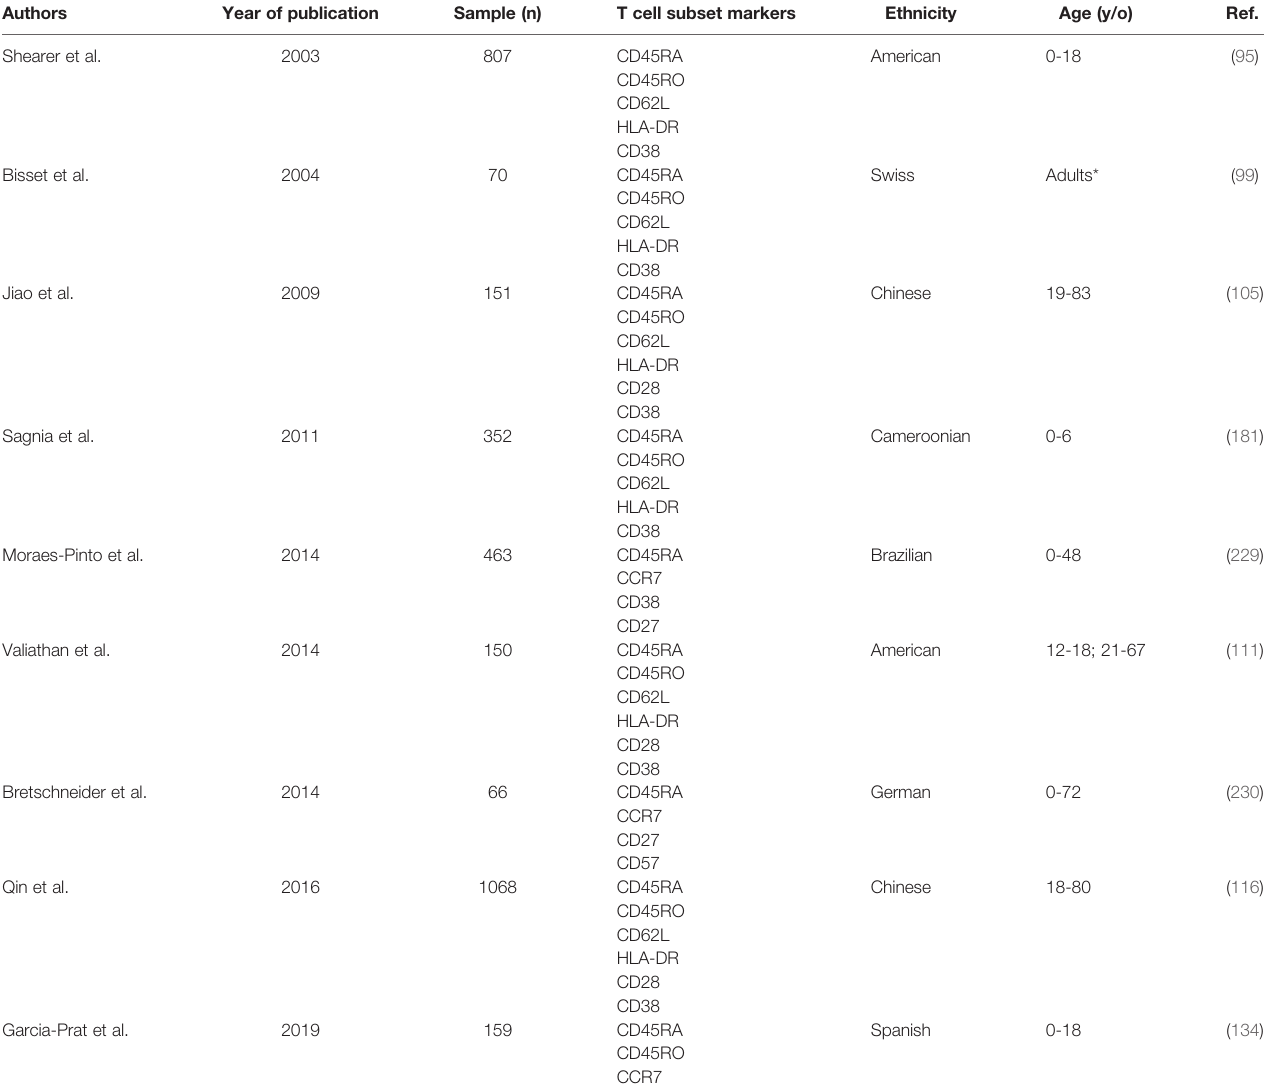
TABLE 5 | Chronology of the main initiatives available in the medical literature for the standardization of circulating naïve and memory T cell subsets, as rated according to the sample number, ethnicity and age range of recruited patients.